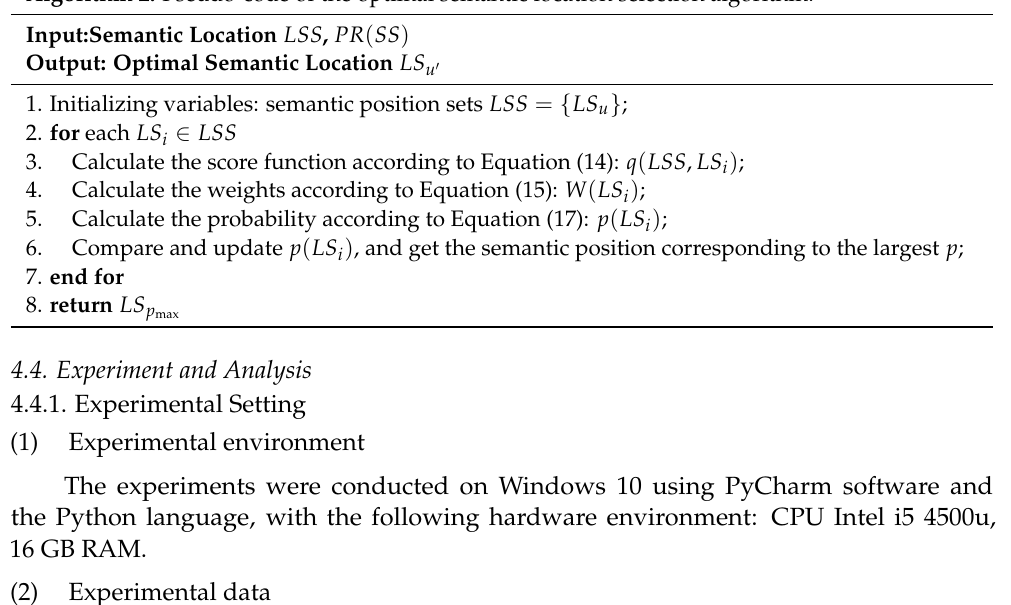
Algorithm 2. Pseudo-code of the optimal semantic location selection algorithm.